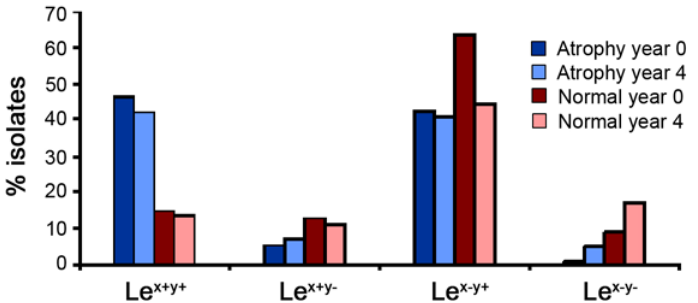
Figure 4. Lewis antigen expression in clinical H.pylori isolates from individuals with atrophy and normal controls. The average percent of Lewis phenotypes (Le x + y + , Le x + y 2 , Le x 2 y + and Le x 2 y 2 ) of single-colony isolates from each individual, categorized as normal or atrophic are shown. Dark blue and light blue-coloured bars: average percent of isolates obtained from atrophic individuals year 0 and year 4, respectively. Dark red and light red-coloured bars: average percent of isolates obtained from normal individuals year 0 and year 4, respectively. Lewis expression was stable over time within individuals and Lewis phenotype frequencies were significantly correlated between year 0 and year 4 (Spearman’s rank correlation P , 0.05).